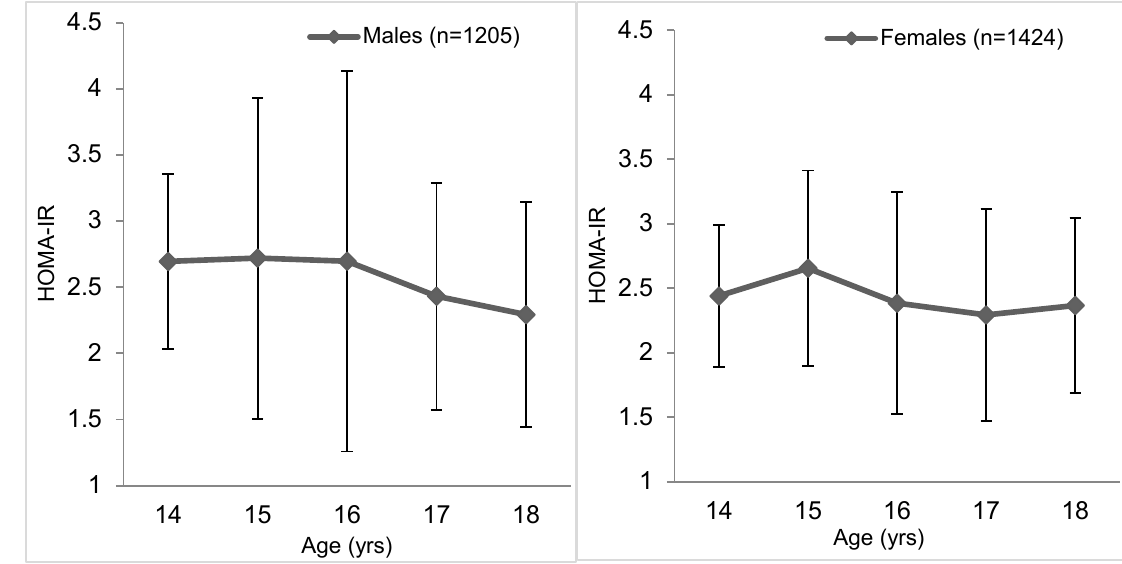
Figure 1. The mean HOMA-IR values in adolescents according to age categories (means and standard deviations).